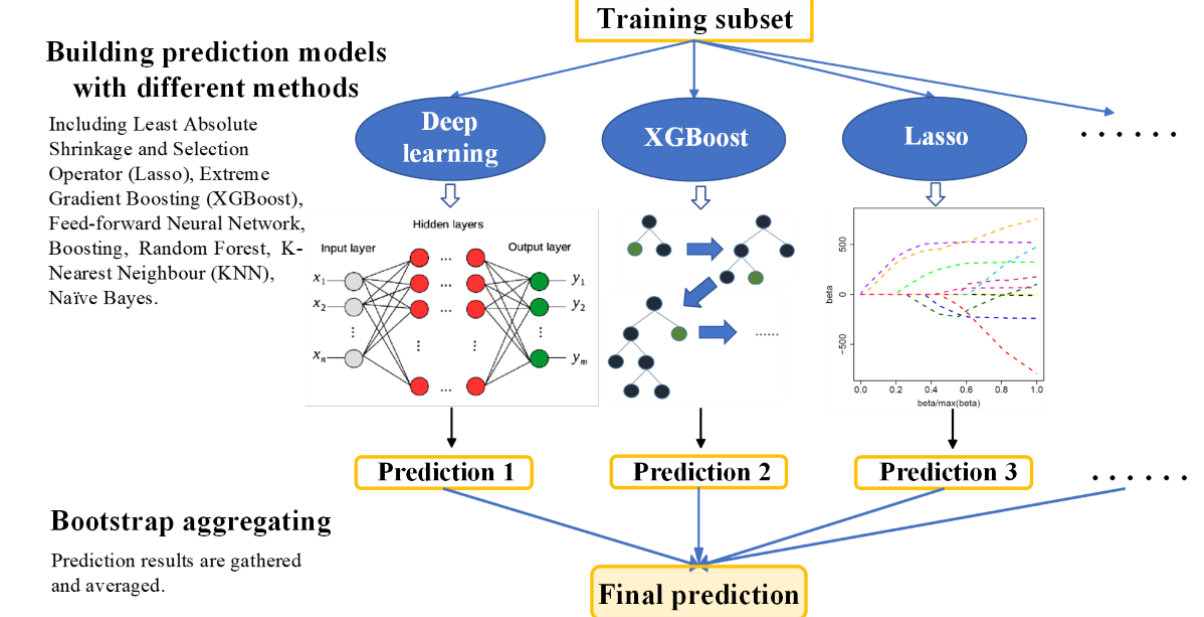
Figure 2. The detailed modeling process with the ensemble learning